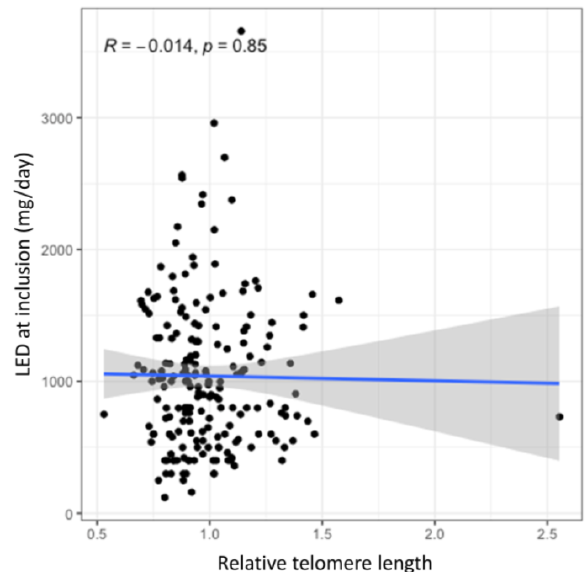
Figure 2. The effect of TL on the current levodopa efficient dose (LED). The blue line presents the regression trendline with the grey area presenting the 95% CI.